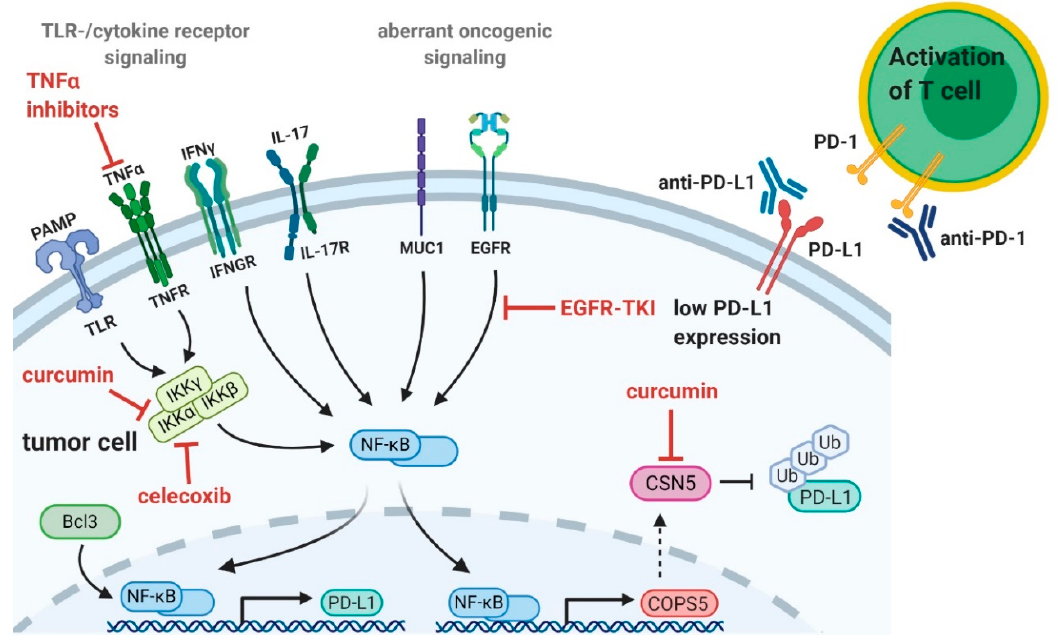
Figure 2. Combinatorial treatment approach of Nuclear factor- κ B (NF- κ B) inhibition and immune checkpoint blockade. Co-administration of nuclear factor κ B (NF- κ B) inhibitors and checkpoint blockade seems to be a promising approach to increase cancer patients’ response rates. NF- κ B inhibition to reduce programmed-death ligand 1 (PD-L1) expression on tumor cells in combination with anti-PD-1/PD-L1 antibodies could be especially effective to enhance anti-tumor immunity. Curcumin and celecoxib can reduce PD-L1 levels by blocking I κ B kinase (IKK) activity and consequently the NF- κ B pathway [119,123]. Curcumin can also inhibit the fifth element of the COP9 signalosome (CSN5)-associated kinase activity leading to PD-L1 destabilization [38]. Blocking of oncogenic epidermal growth factor receptor (EGFR) signaling by EGFR-tyrosine kinase inhibitors (EGFR-TKIs) can attenuate NF- κ B activity and reduce PD-L1 expression [103]. Combinatorial treatment of EGFR-TKIs and immune checkpoint blockade might prolong duration of response and prevent resistance [124,125]. Tumor necrosis factor α (TNF α ) inhibition can reduce adverse events and increase efficacy of immune checkpoint blockade [126]. Arrows indicate paths to NF- κ B activation, dotted arrows indicate protein translation and translocation, T-bars indicate inhibition. Figure 2 was created with BioRender.com.